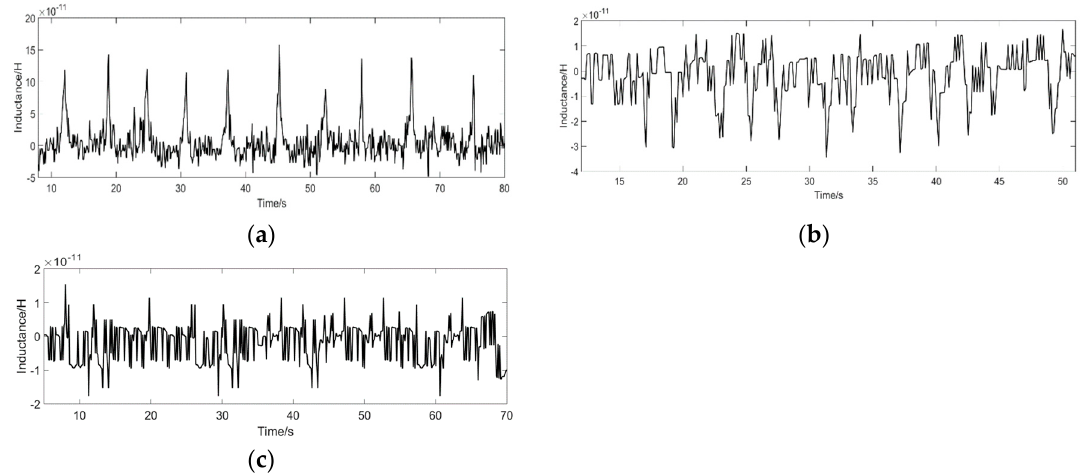
Figure 11. Sensor coil 300 turns, excitation frequency 2 MHz ( a ) detection signal value of 10 µ m iron particles; ( b ) detection signal value of 60 µ m copper particles; ( c ) test results of iron particles less than 10 µ m and copper particles less than 60 µ m, no signal value.